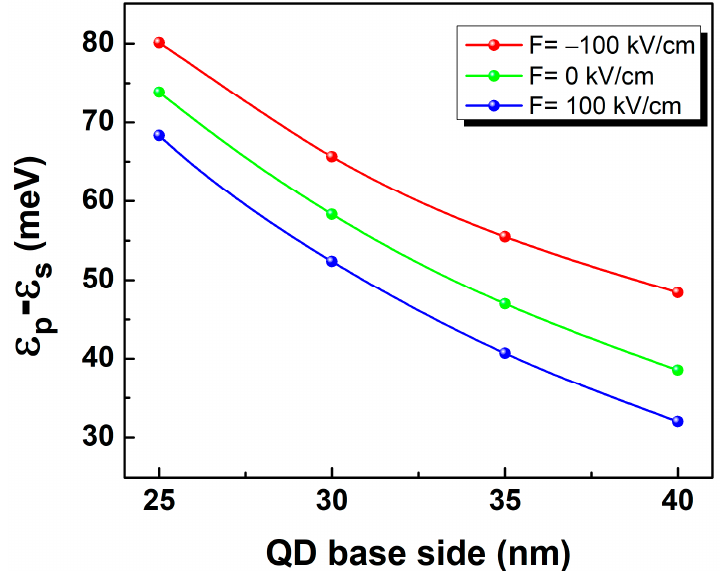
Figure 2. QD size dependent transition energy (𝜖 (cid:3043) − 𝜖 (cid:3046) ) for F = 100kV/cm, 0 kV/cm and − 100 kV/cm.